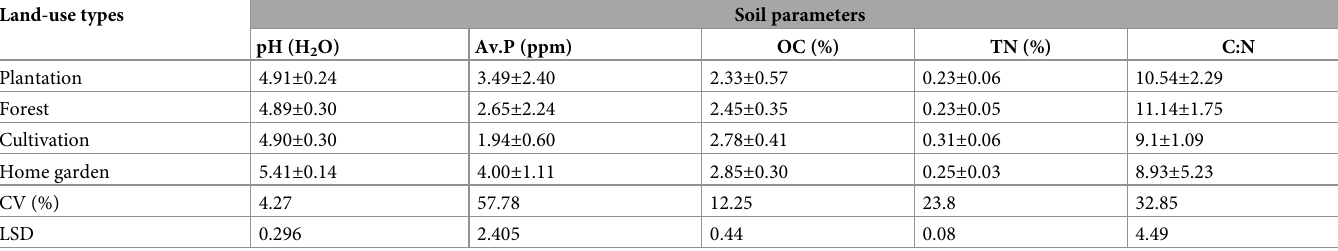
Table 1. Mean value ( ± SDM) of soil pH, available phosphorous, organic carbon, total N, and carbon to nitrogen ratio with different land-use. Land-use types Soil